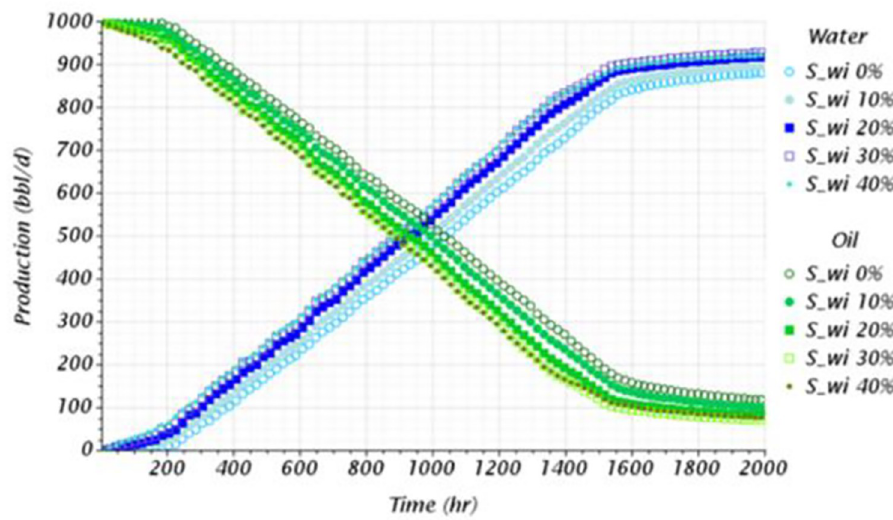
Fig 11. Production profile obtained for the S wi sensitivity